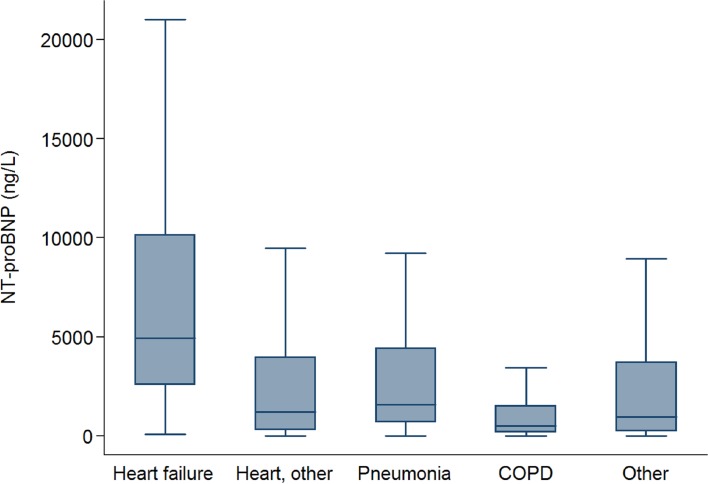
Median and interquartile range values of NT-proBNP according to diagnosis groups.